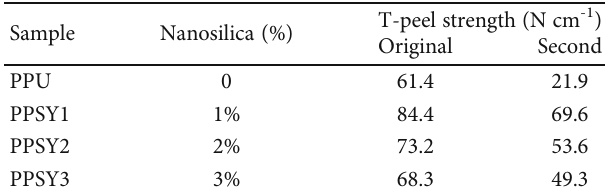
Figure 9: SEM images of the samples: (a) PPU, (b) PPSI, (c) PPST, and (d) PPSY. Scale bar is 500 μ m. Table 3: The e ff ect of nanosilica content on the T-peel